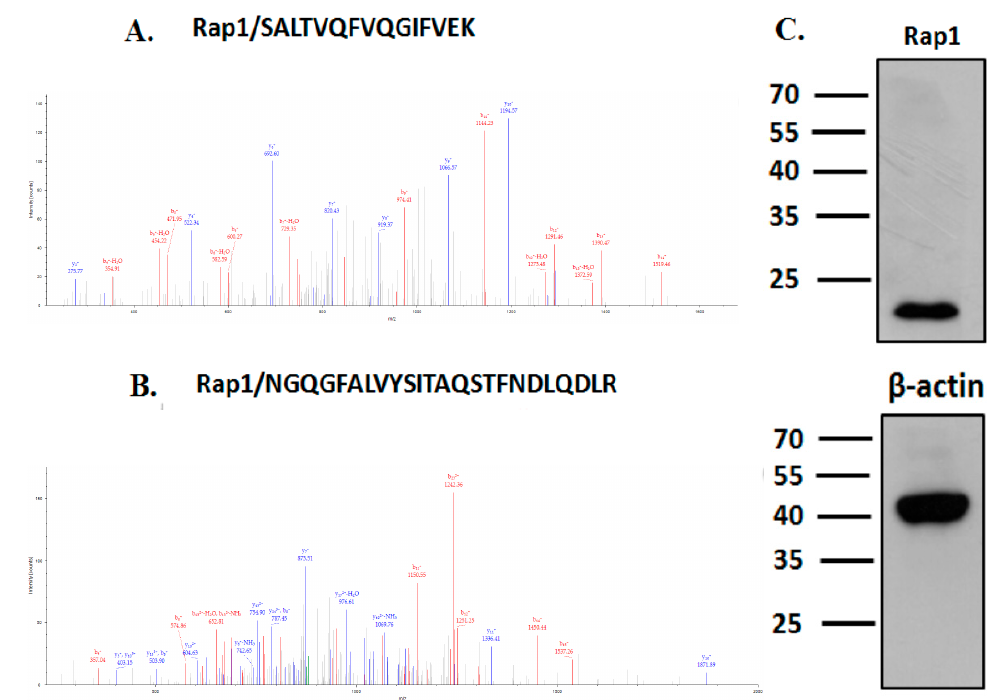
Figure 1. Identification of interactors of TBC1D21 through co-immunoprecipitation (co-IP) and nano LC–MS/MS. ( A , B ) Tandem mass spectrometry (MS/MS) spectrum of the tryptic peptides of Rap1: SALTVQFVQGIFVEK and NGQGFALVYSITAQSTFNDLQDLR. ( C ) Immunoblotting (IB) of NTERA-2 cl.D1 (NT2D1) cell lysates with the anti-Rap1 and anti- β -actin antibodies.